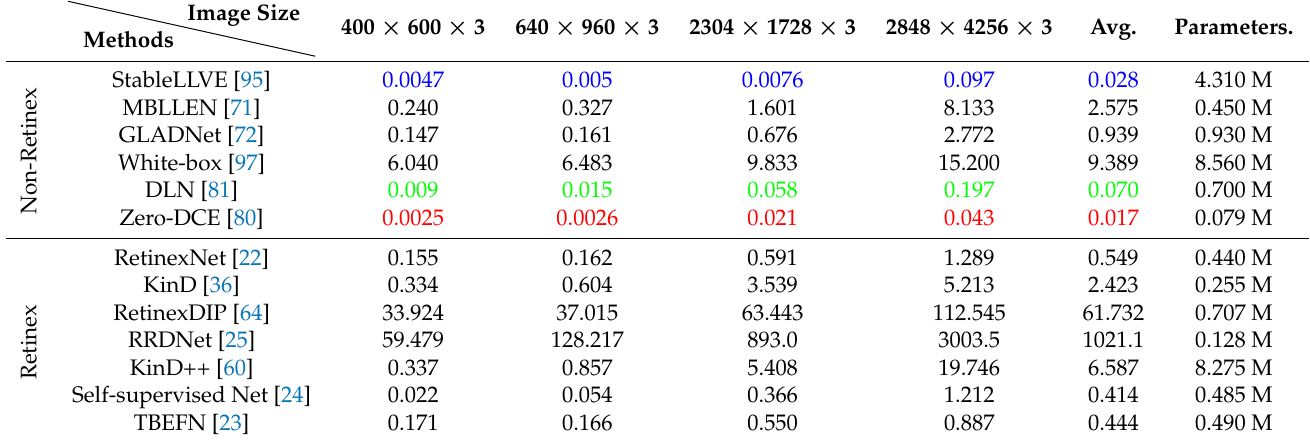
Table 6. The computation time (seconds) and number of parameters (millions) for deep learning- based methods on GPUs (NVIDIA TITAN Xp) are reported. The red, blue, and green colors are used to indicate the best, second best, and third best performance,